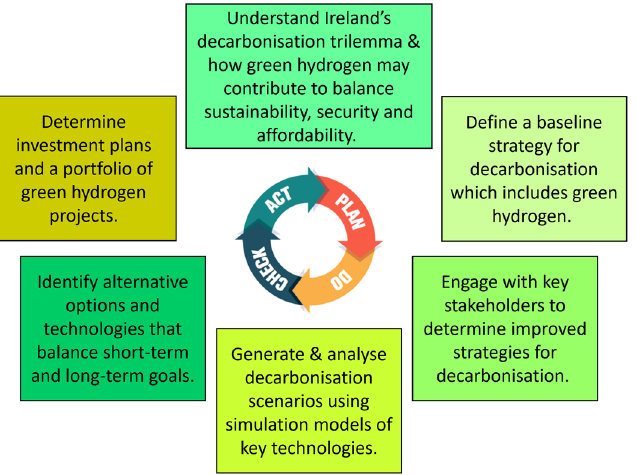
Figure 4. Process to determine a decarbonization strategy based on green hydrogen.